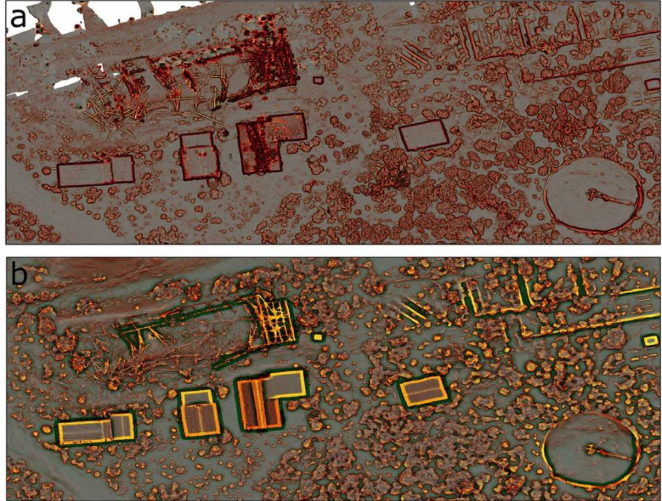
Figure 13. Visualization of the multitemporal Roseklip Mill area point clouds in our instance of Potree. ( a ) Shows our custom Local Relief colorization of the 2015 dataset; ( b ) shows our custom Local Relief colorization of the 2015 dataset. Colorization variation is due to the different resolutions of the source point clouds. Visualizations by S. McAvoy and G. Jim é nez